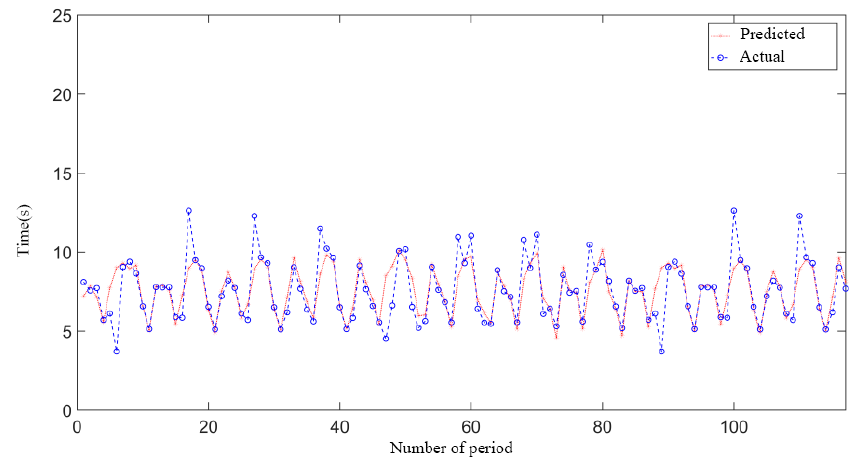
Figure 10. Comparison between predicted results and actual results of rolling period. Table 3. Limitations of the gangway model.